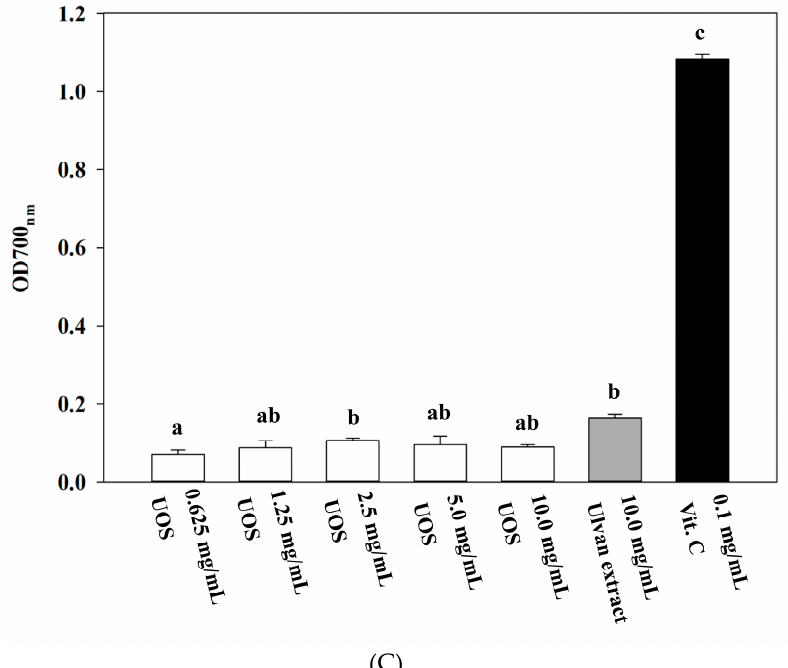
Figure 4. Antioxidant activities of ( A ) DPPH scavenging activity, ( B ) ferrous chelating activity, and ( C ) reducing powder on ulvan extract and ulvan oligosaccharides (UOS). DPPH assay: absorbance was measured at 517 nm. Ferrous ion chelating assay: absorbance was measured at 562 nm. Reducing power assay: absorbance was measured at 700 nm. Bars with different letters are statistically different ( p < 0.05).